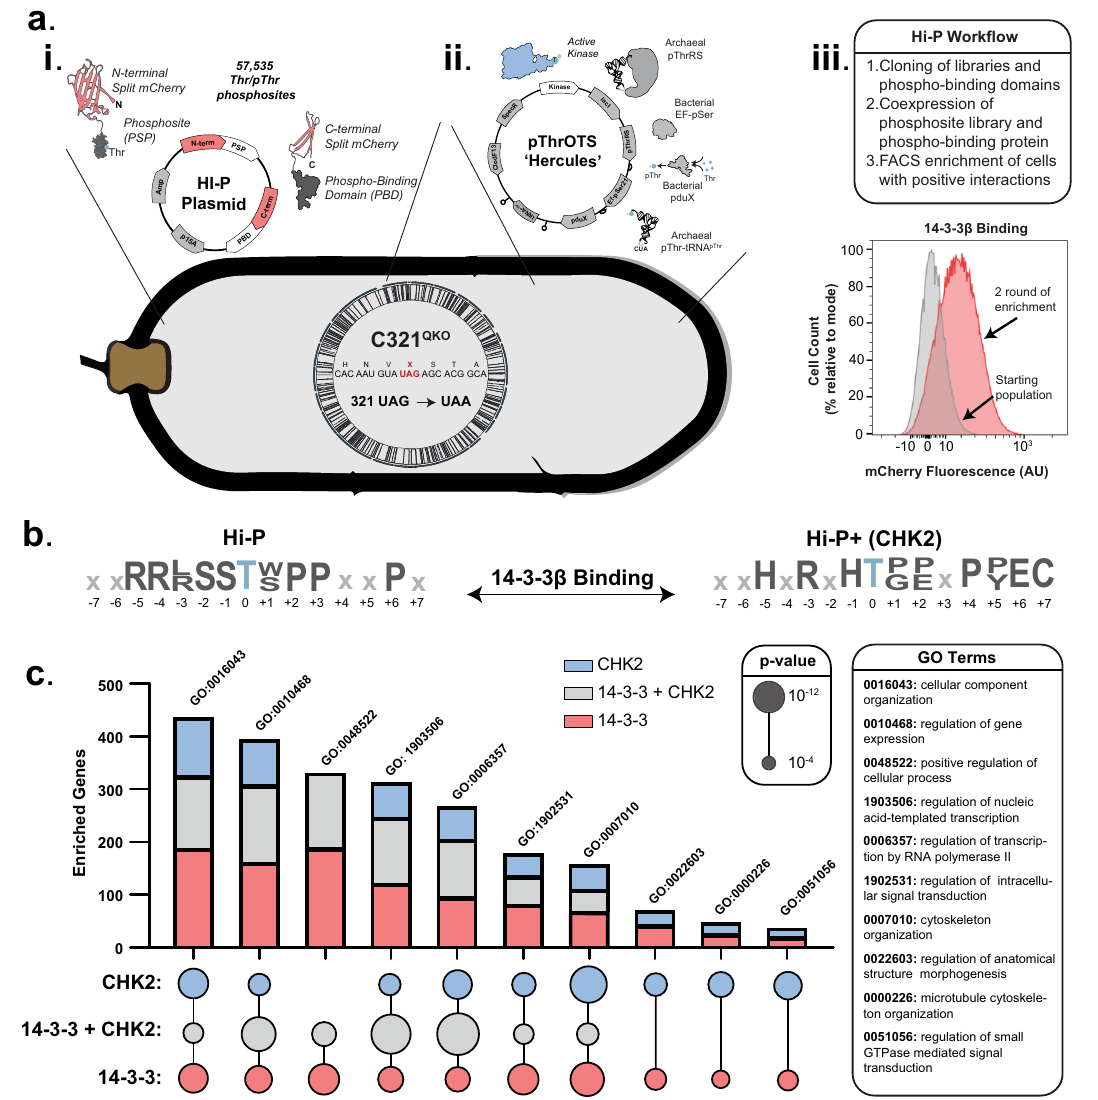
Fig. 5 | Hi-P+ enables the identi fi cation of multi-level, phosphorylation- dependent PPIs. a Overview of Hi-P+experimental work fl ow. (i) Hi-P platform enablesphosphorylation-dependentreconstitutionof asplitmCherryreporter.(ii) Composition of pThrOTS Hercules , a modi fi ed pThrOTS vector harboring a kinase dependent on pThr-mediated activation (pThr383 CHK2 KD). (iii) Example of 14-3- 3 β Hi-P analysis and successive rounds of fl uorescent (interaction positive) cell enrichment by FACS. b Motif analysis of enriched pThr phosphosites interacting with 14-3-3 β (left) and Thr-phosphosites interacting with 14-3-3 β inthe presenceof